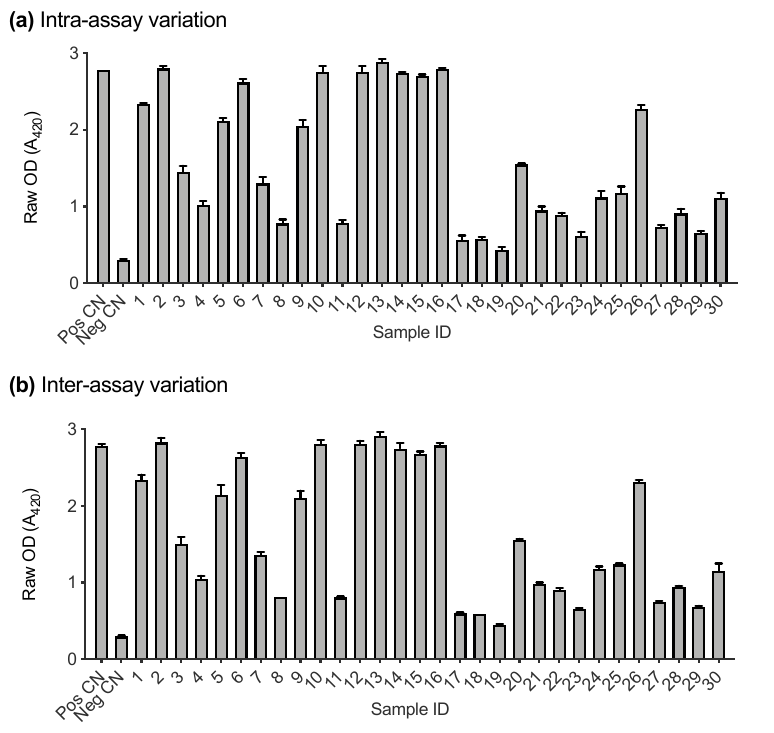
Figure 4. Intra- and inter-assay variation of FeLV-A SU ELISA. ( a ) Variation between samples tested in triplicate on the same plate. ( b ) Variation between samples tested on two different plates on two different days. Error bars represent standard deviation which was ≤ 0.13 in all cases.